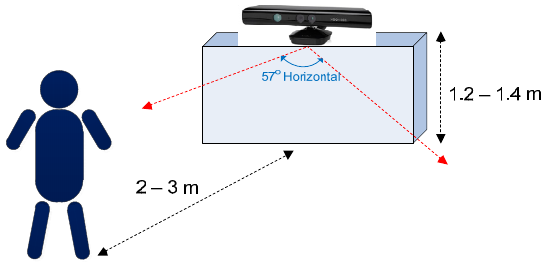
Figure 3. Standard parameters to install Kinect in outer